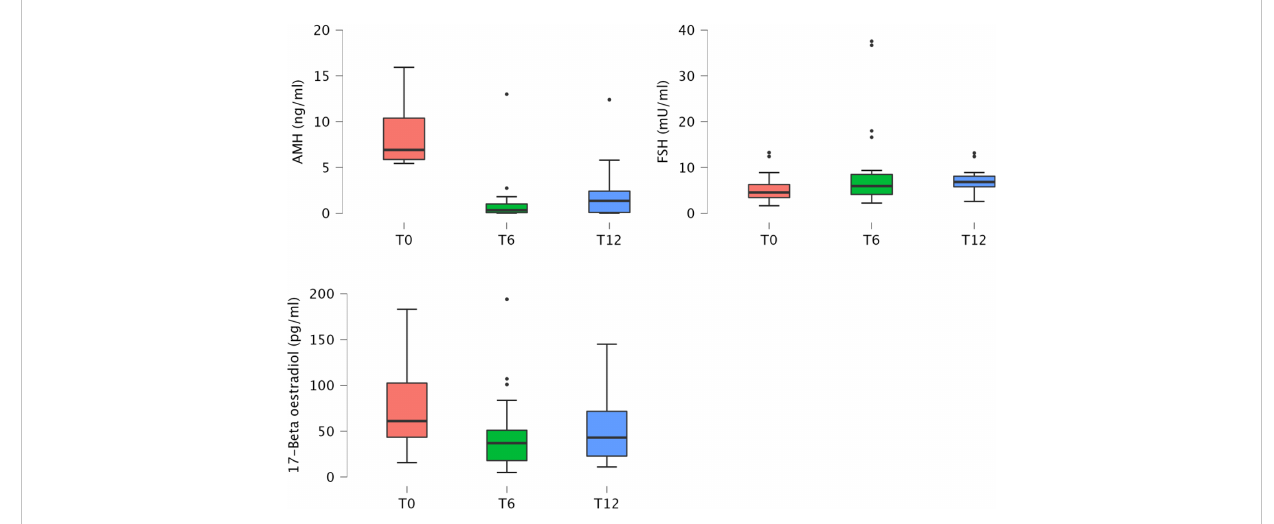
FIGURE 1 Boxplot of anti ‐ müllerian hormone, follicle stimulating hormone and 17 b -oe levels at baseline and during the follow ‐ up visits.